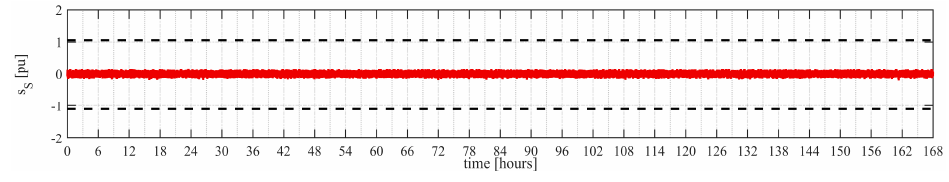
Figure 16. The S power profiles achieved by OPEM over a generic week at T = 24 h.